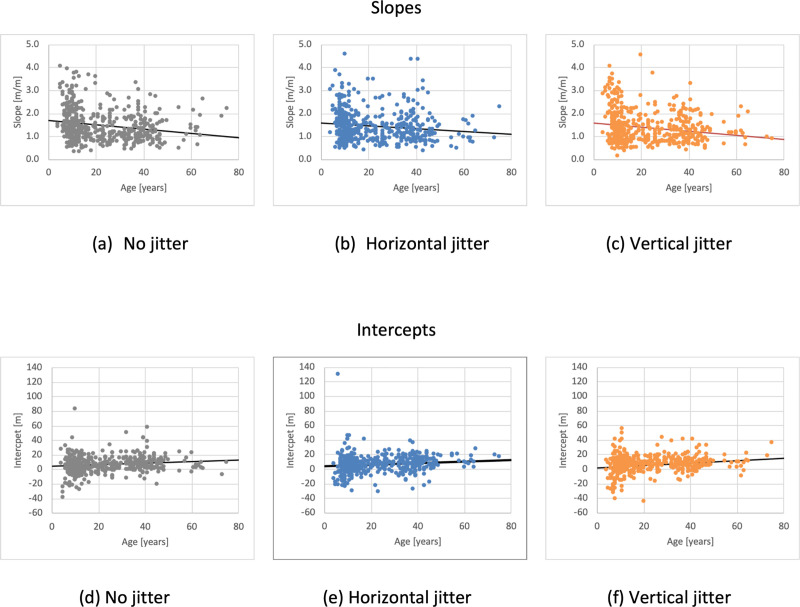
Linear regressions.Linear regressions through the model parameters as a function of age. Top row shows the effect of age on slopes for no jitter (a), horizontal jitter (b) and vertical jitter (c). Bottom row shows the effect of age on intercepts for the same three groups.